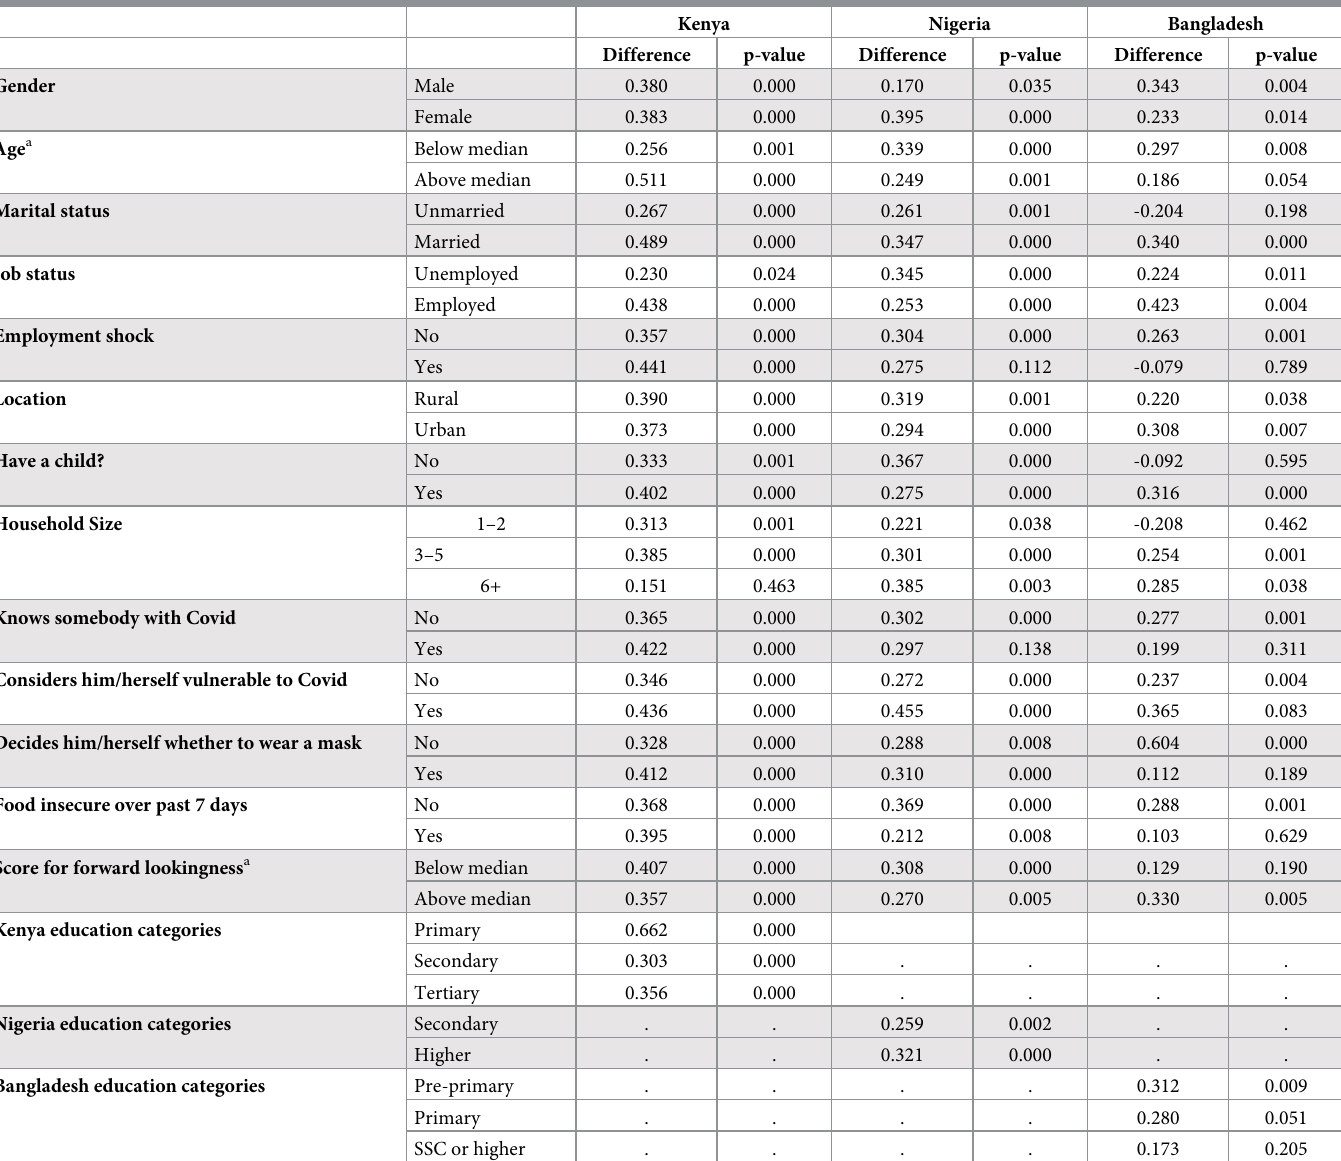
Table 4. Comparing stated and elicited facemask compliance by baseline socioeconomic and demographic determinants in all 3